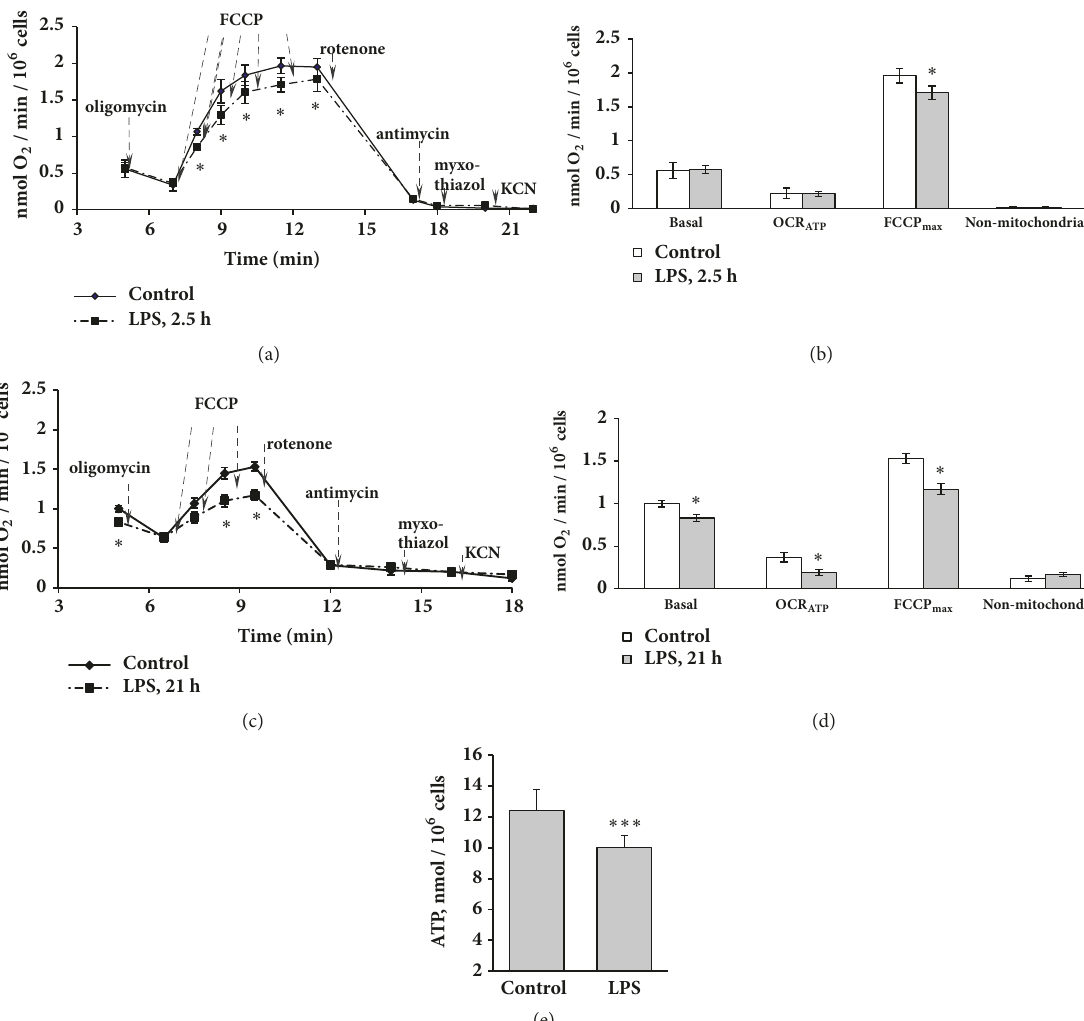
Figure 3: Effect of LPS on the oxygen consumption rate under different respiratory conditions and on ATP synthesis. OCR by FUBEC incubated with or without LPS (25 𝜇 g/ml) for 2.5 h (a, b) and 21 h (c, d) was analyzed. ((a), (c)) Respirometry experiments; ((b), (d)) quantification of data. Arrows indicate the addition of drugs. n=6 independent experiments. ( e ) ATP production by FUBEC, incubated with or without LPS (25 𝜇 g/ml, 21 h), n=22. ∗ a < 0.05; ∗∗∗ a < 0.001 versus